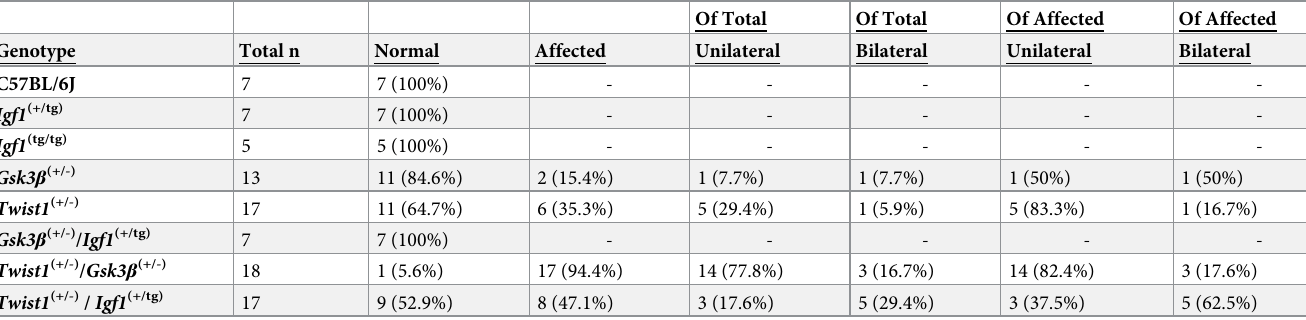
Table 2. Phenotypes of each mouse strain and heterozygous